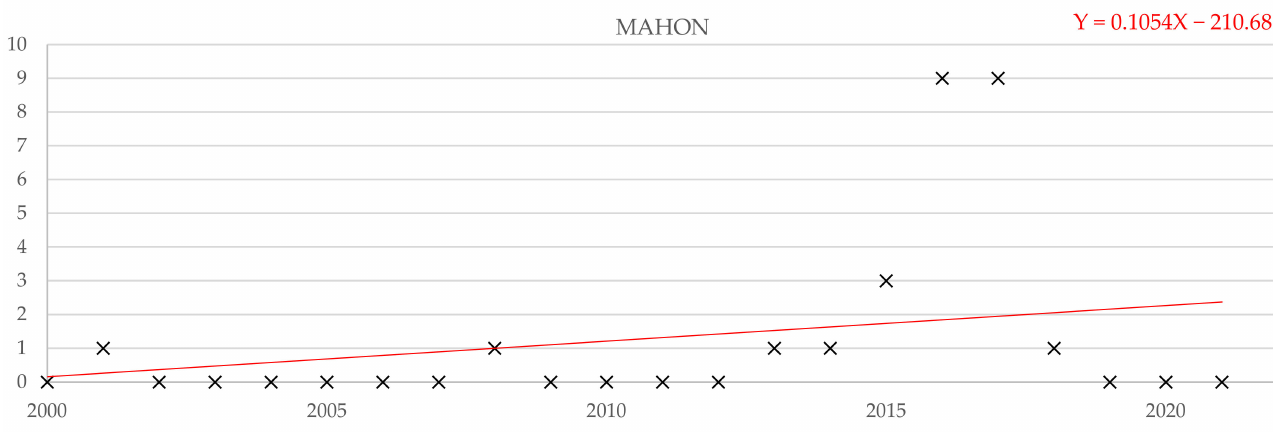
Figure 29. Number of times Tp has exceeded the expected Tp in 100 years in Gata.